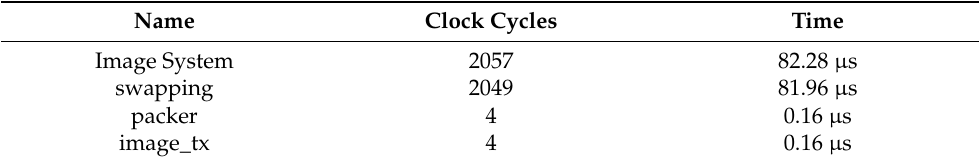
Table 8. Latency of the imaging system.